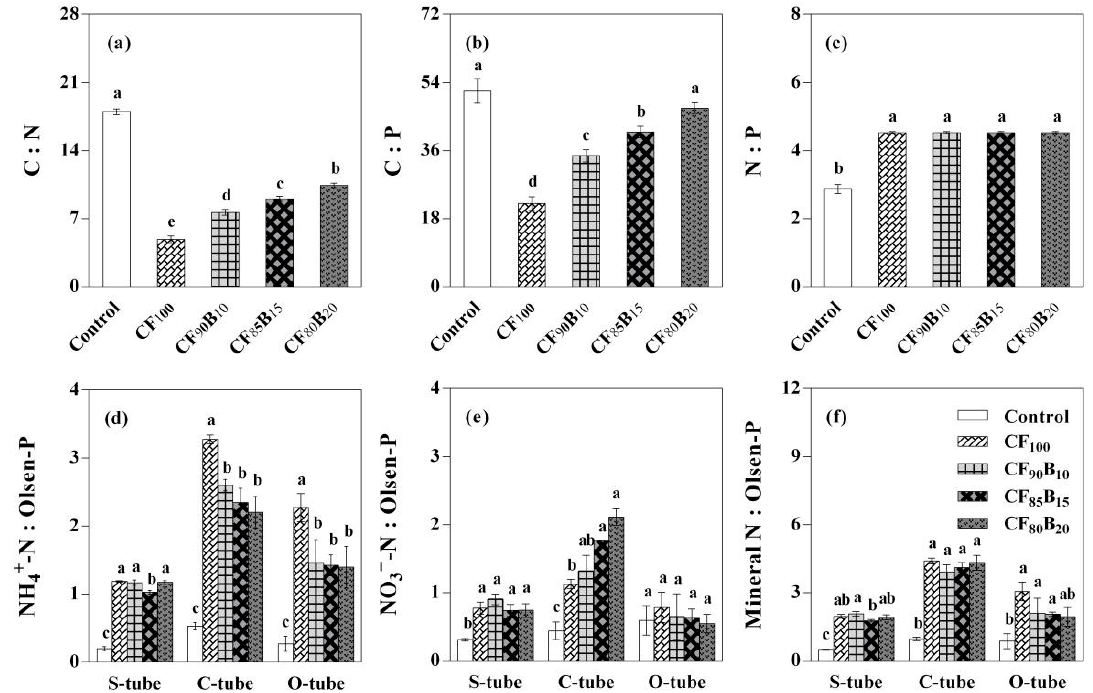
Figure 5. Coupled effects of reduced chemical fertilization and palm silk biochar (PSB) supplementation on the molar ratios of C:N ( a ), C:P ( b ), and N:P ( c ) in 0–10 cm soil layer, and NH 4+ -N:Olsen-P ( d ), NO 3 − -N:Olsen-P ( e ), and mineral N:Olsen-P ( f ) in 0–40 cm soil layer. Abbreviations: S-tube, starting tube; C-tube, top-covered tube; O-tube, top-open tube. Treatments: Control, no fertilization; CF 100 , 100% conventional fertilization; CF 90 B 10 , 90% conventional fertilization plus 10% PSB-based fertilization; CF 85 B 15 , 85% conventional fertilization plus 15% PSB-based fertilization; CF 80 B 20 , 80% conventional fertilization plus 20% PSB-based fertilization. Data are expressed as means ± SD ( n = 3). For each tube type, bars labeled with different lowercase letters (e.g., a, b, c, etc.) indicate significant ( p < 0.05) differences among the treatments based on the Tukey test or Games–Howell test.